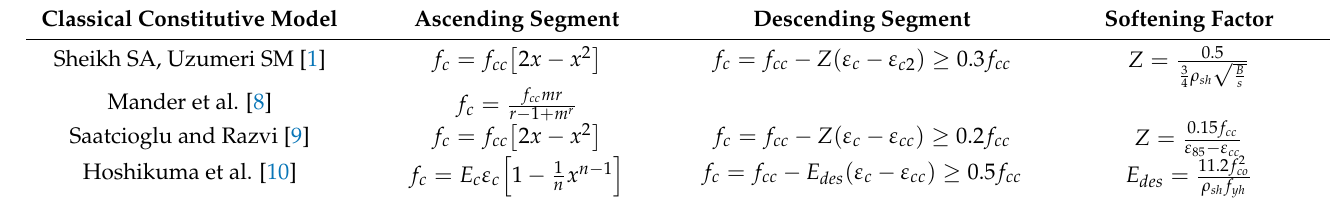
Table 2. Expression of constitutive model of SRC